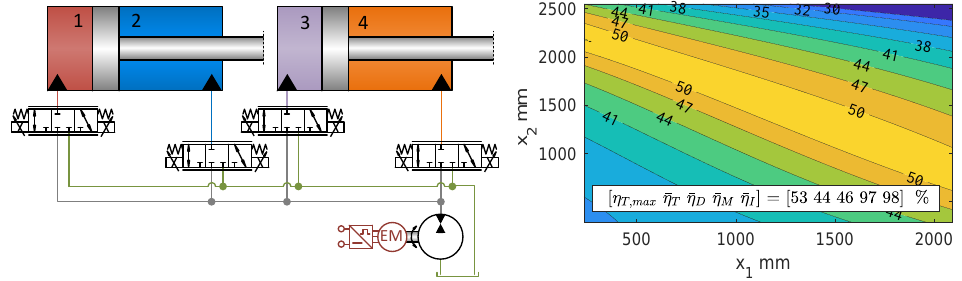
Figure 17. Valve actuated crane application with separate metering supplied by variable-speed displacement unit, and associated efficiency under payload retraction, ˙ x 1,max = − ˙ x 2,max = 50 mm/s. Under payload extension, the efficiency is zero as this is a load aiding